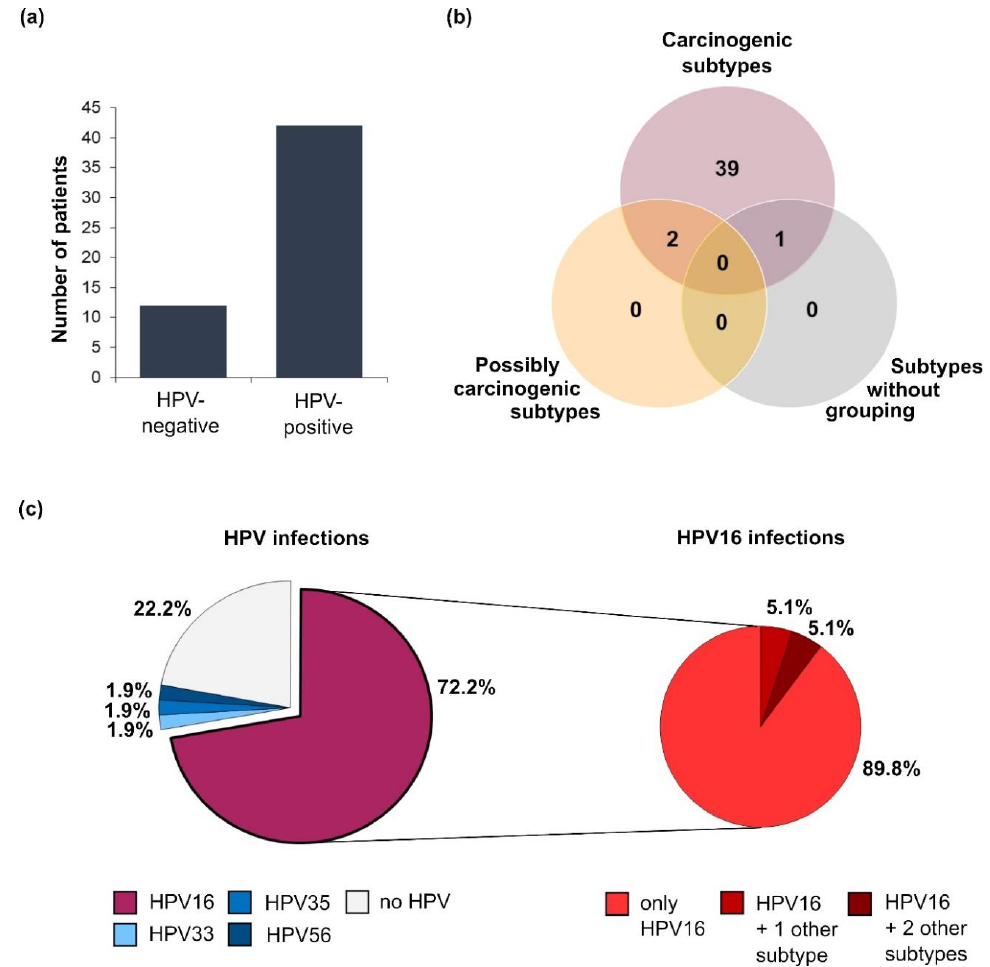
Figure 2. Distribution of HPV infections among the study participants ( n = 54). ( a ) Bar chart illustrating the number of patients infected with different HPV subtypes; ( b ) number of HPV-positive patients harboring HPV subtypes categorized as carcinogenic, possibly carcinogenic, or not grouped according to the International Agency for Research on Cancer (IARC) classification; ( c ) pie charts showing the percentage of HPV infections grouped by subtype (left). About 10% of the patients harboring HPV16 were infected with multiple subtypes (right).